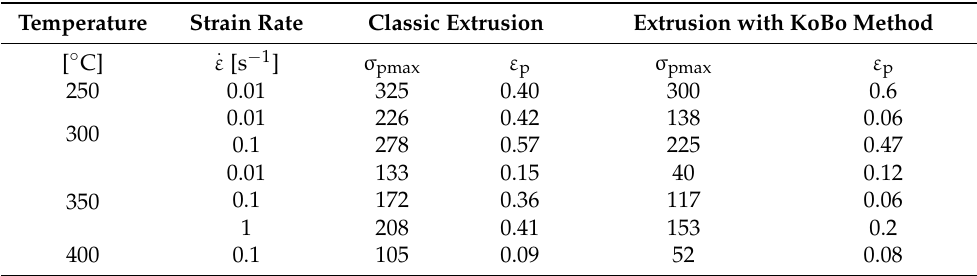
Figure 6. Flow stress of the investigated WE43 alloy after deformation at various temperatures: ( a ) Table 3. The determined values of flow stress σ pmax and the corresponding strain ε p after an axial- symmetric compression test in the temperature range of 250–350 ◦ C at a strain rate of 0.01–1 s − 1 . Temperature Strain Rate Classic